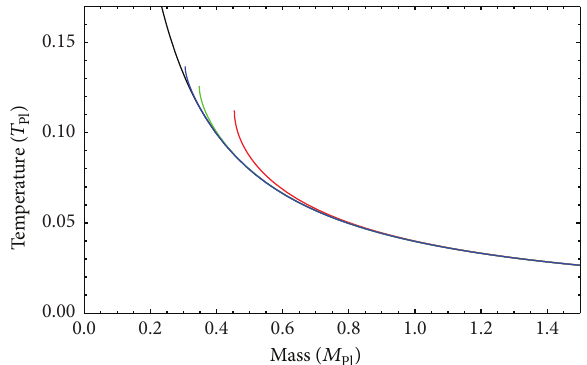
Figure 2: The temperature versus the black hole mass for the case 𝛼 = 1 . Curves are the Hawking result (black) and GUP 𝑛 = 2 (red), 𝑛 = 5 (green), and 𝑛 = 10 (blue), respectively.